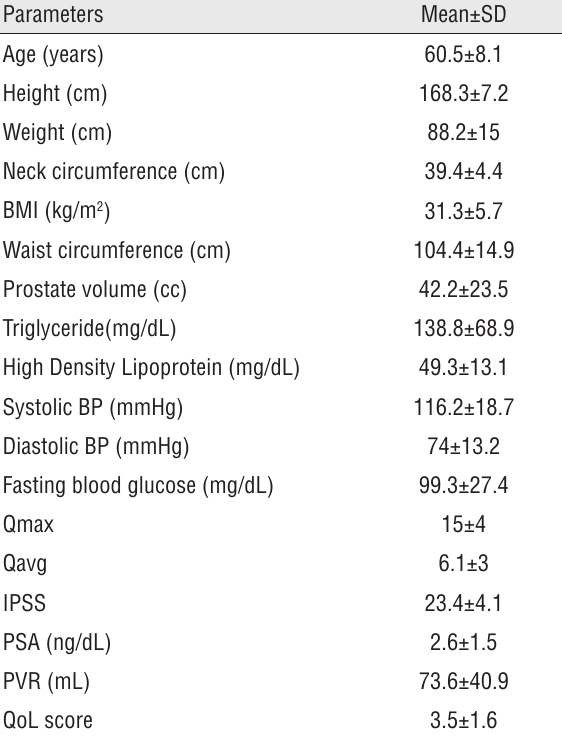
Table 1 - Baseline demographic data in all patients